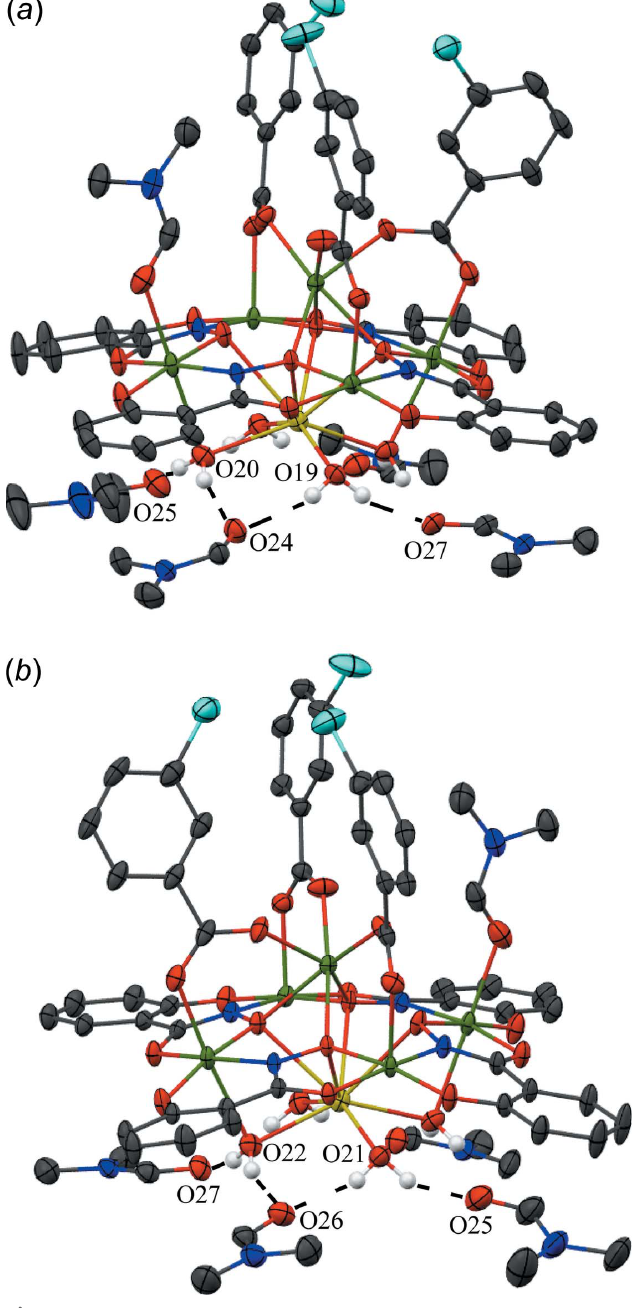
Figure 5 Intermolecular hydrogen bonding in 2 between the water molecules coordinated to the Na + ion and the carbonyl oxygen atoms of the lattice DMF molecules. For clarity the interactions have been divided into two sections ( a ) and ( b ), only the hydrogen atoms (white) of the water molecules have been included, the disorder and the partially occupied water molecule have been omitted, and only the atoms involved in the interactions have been labeled. See Fig. 1 for additional display details.